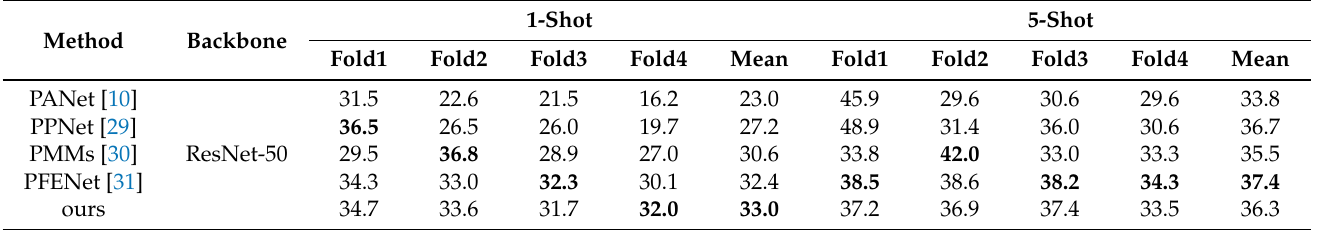
Table 3. Mean-IoU of 1-way on COCO-20 i . Bold numbers represent the best data in the comparison experiment.